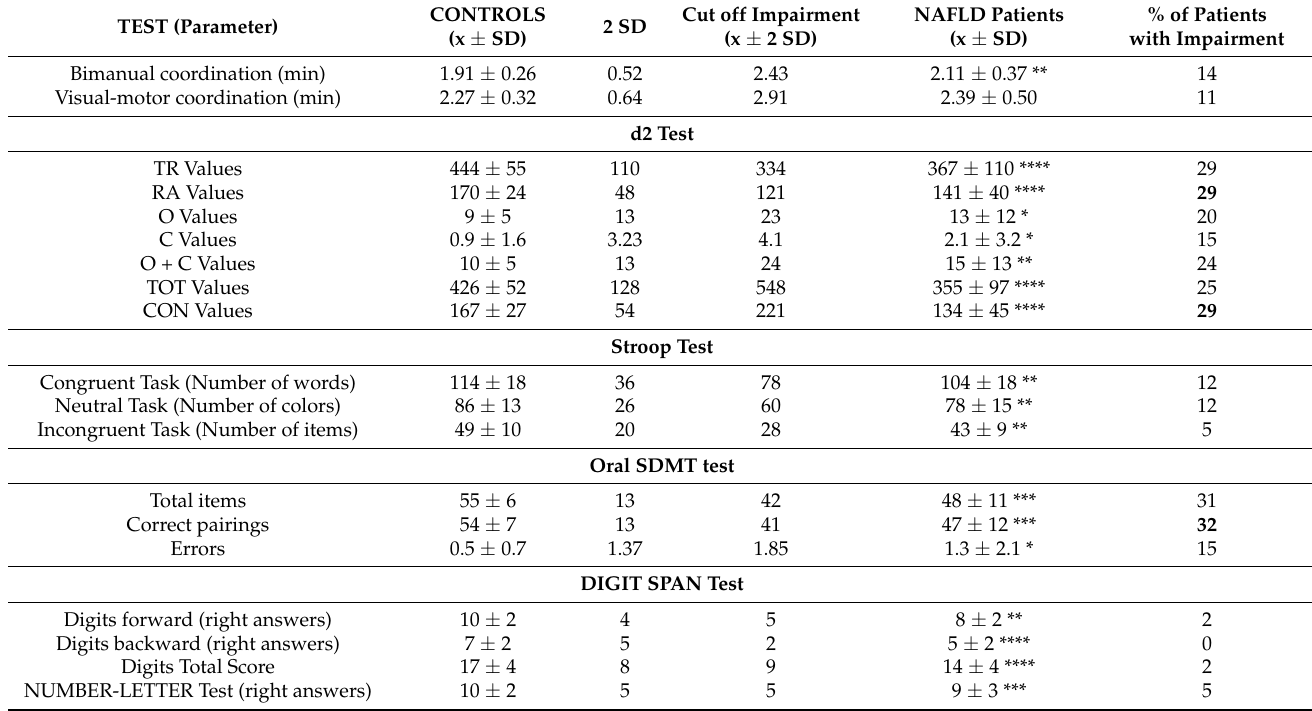
Table 2. Cutoff and proportion of NAFLD patients showing cognitive impairment for each psychometric test parameter. TEST